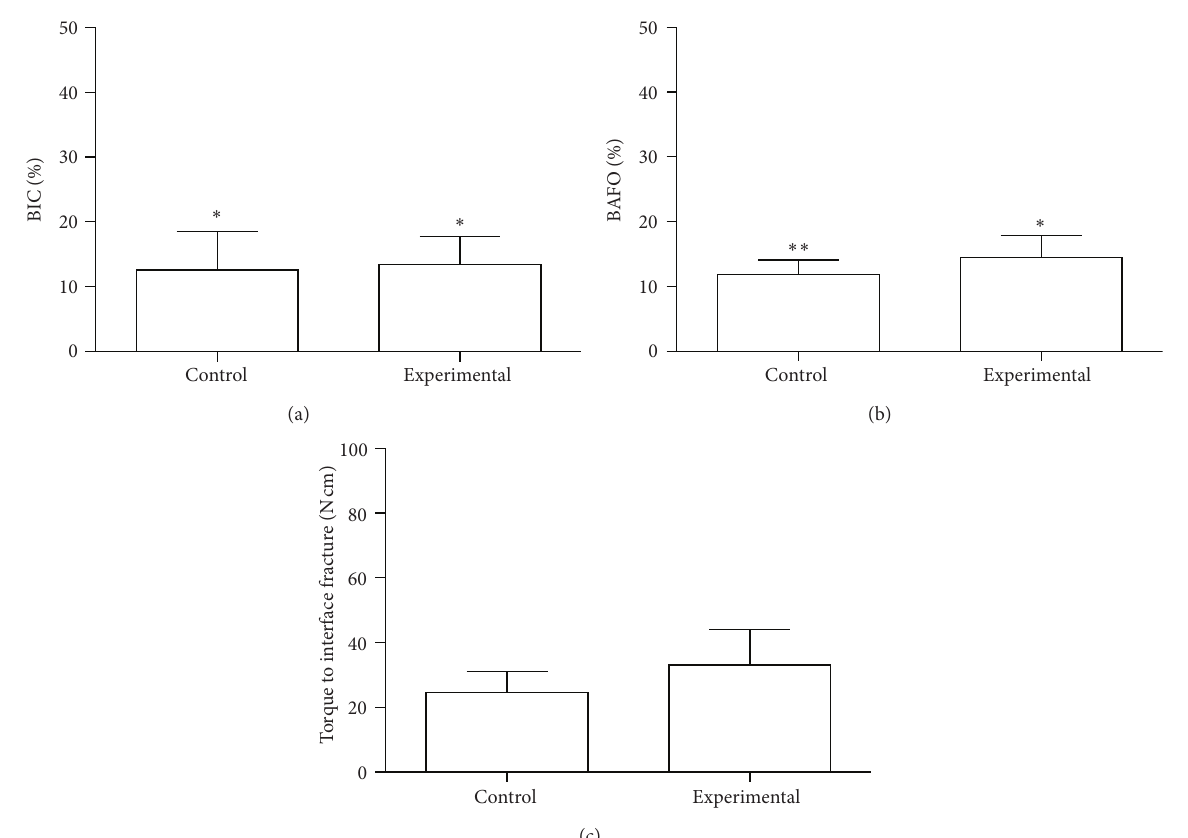
F2:(a)Bone-to-implantcontact(BIC),(b)boneareafractionoccupancy(BAFO)percentages,and(c)rawtorquedata(mean for the control and experimental groups in the experimental period. e number of asterisks depicts statistically homogeneous groups.